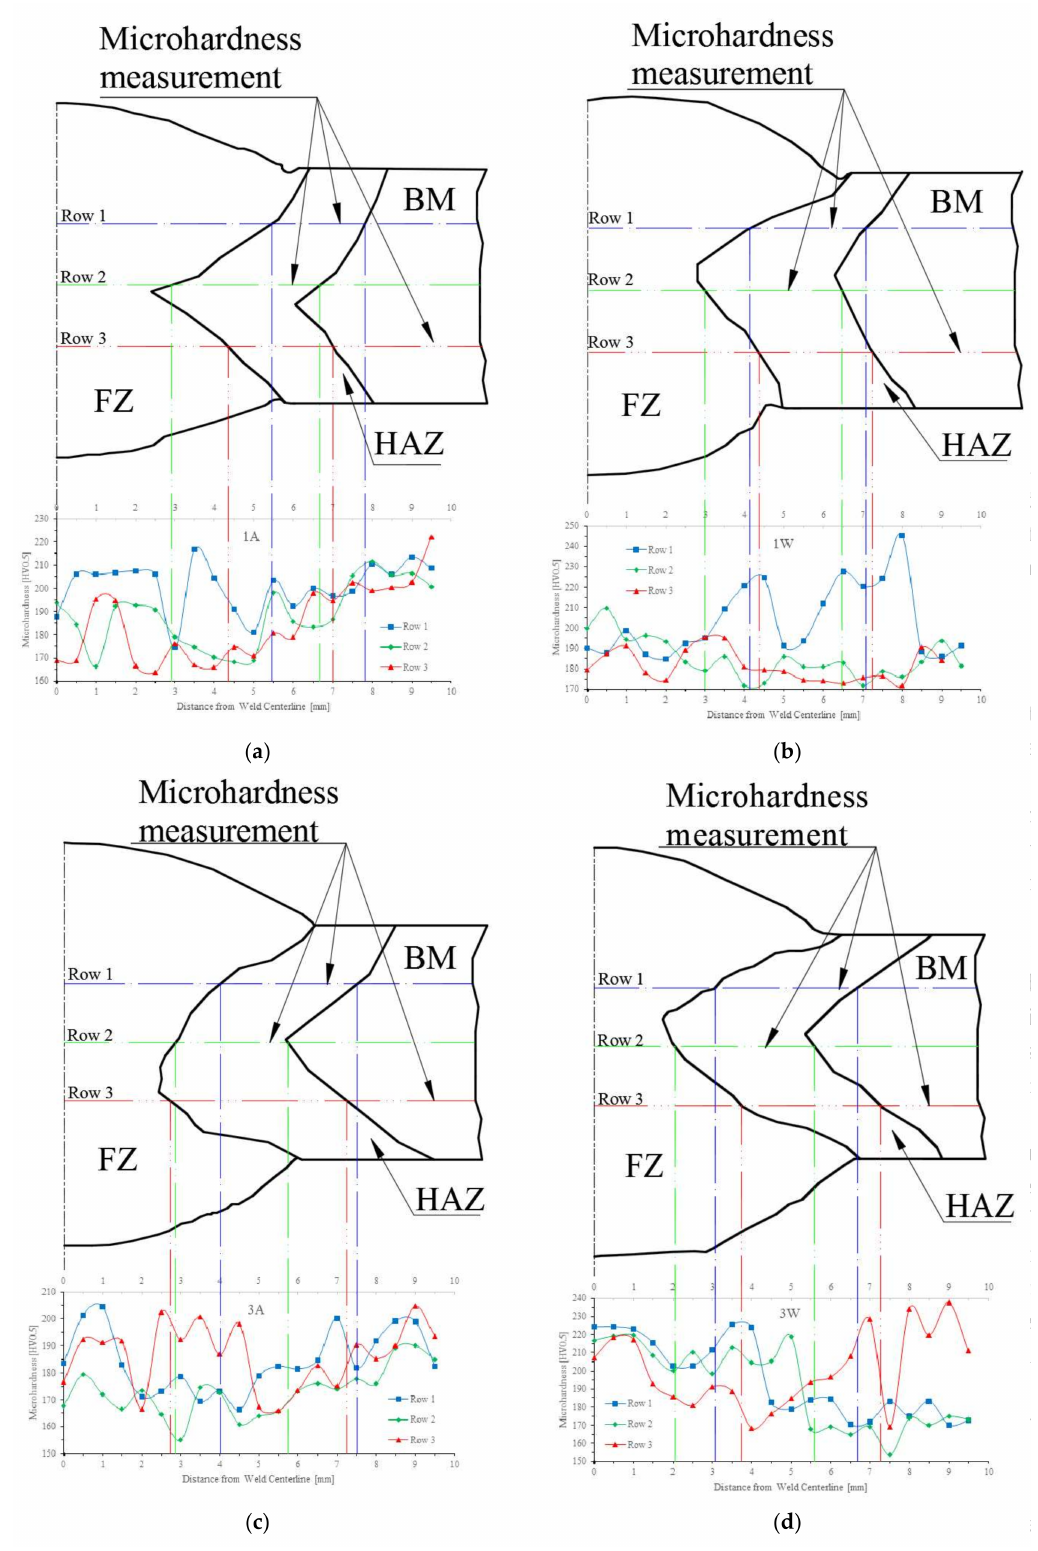
Figure 17. Microindentation hardness profiles for specimens of each treatment: ( a ) specimen 1S; ( b ) specimen 1F; ( c ) specimen 3S; and ( d ) specimen